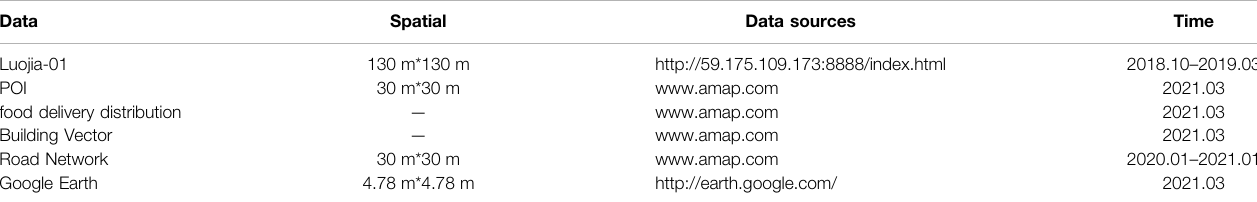
TABLE 1| Characteristicsofthedataused inthisstudy(Therearesevenkindsofdatausedinthisstudy,amongwhichthesources,acquisitionmethodsand accesstime of different data are shown in the table).